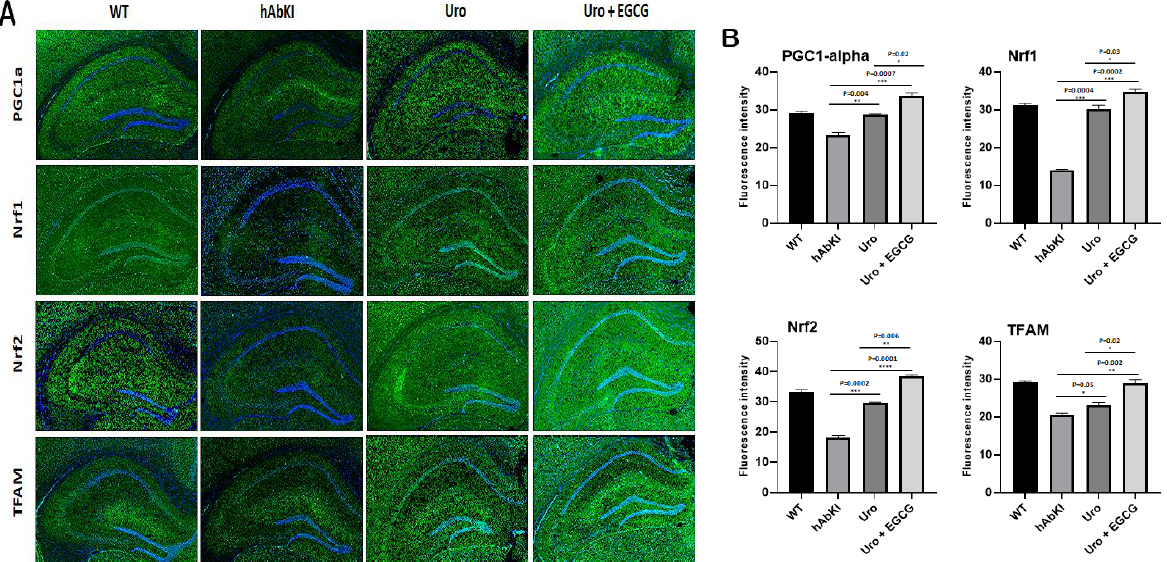
Figure 9. Immunofluorescence analysis of hippocampal mitochondrial biogenesis proteins in seven- month-old hAbKI mice and treated hAbKI mice with Urolithin A and EGCG. ( A ) Representative immunofluorescence images and ( B ) quantitative analysis of mitochondrial biogenesis proteins, PGC1a, Nrf1, Nrf2 and TFAM in hAbKI mice and treated hAbKI mice with Urolithin A and EGCG. Synaptic and mitophagy proteins: Our immunofluorescence analysis revealed that mitophagy proteins (PINK1 p = 0.0004 and Parkin p = 0.001) and synaptic protein synap- tophysin ( p = 0.0002 and PSD95 p = 0.005) were increased in urolithin A-treated hAbKI mice relative to untreated hAbKI mice (Figure 10A,B). These effects are higher in the com- bined treatment of urolithin A+EGCG for mitophagy (PINK1 p = 0.0003 and Parkin p = 0.0003) and synaptic proteins ( p = 0.0001 and PSD95 p = 0.0001) (Figure 10A,B) in the hip- pocampus of hAbKI mice. Immunoreactivities of mitophagy proteins PINK1 ( p = 0.02), Parkin ( p = 0.01) and synaptic proteins synaptophysin ( p = 0.02) and PSD95 ( p = 0.001) were significantly increased in hAbKI mice treated with urolithin A relative to the combination treatment of urolithin A+EGCG, indicating that combination treatment is better and stronger than urolithin A alone for mitophagy and synaptic activities.